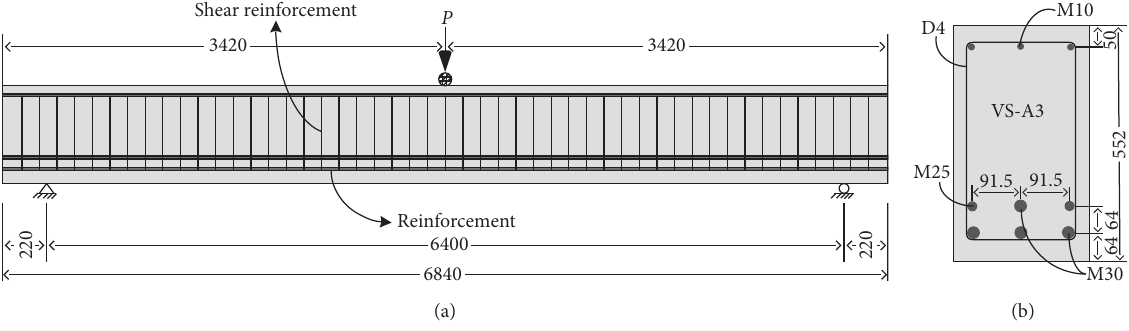
Figure 4: The geometry and reinforcement details of VS-A3 beam [17].